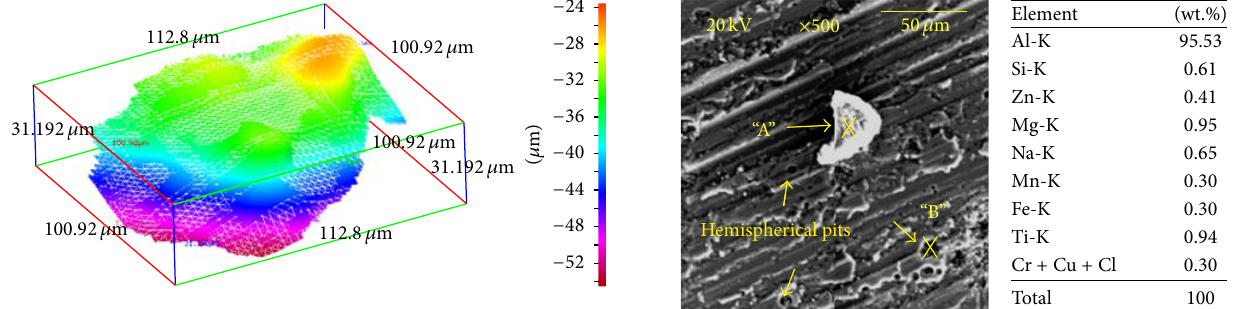
Figure 9: 3D presentation of “elliptical” corrosion pit in the untreated specimen. Figure 10: Untreated specimen’s surface after corrosion and EDS results for point